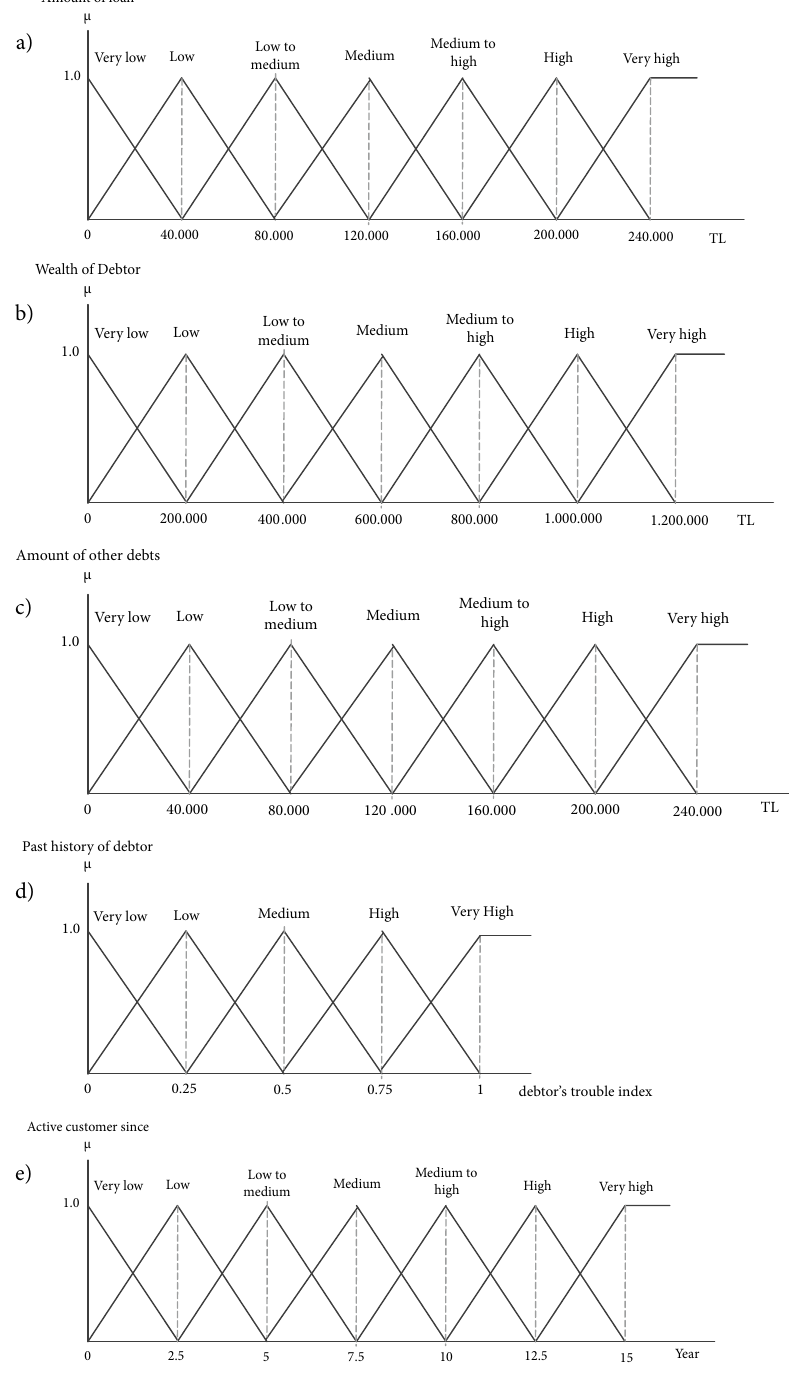
Figure 3. Credit debt inputs and their membership